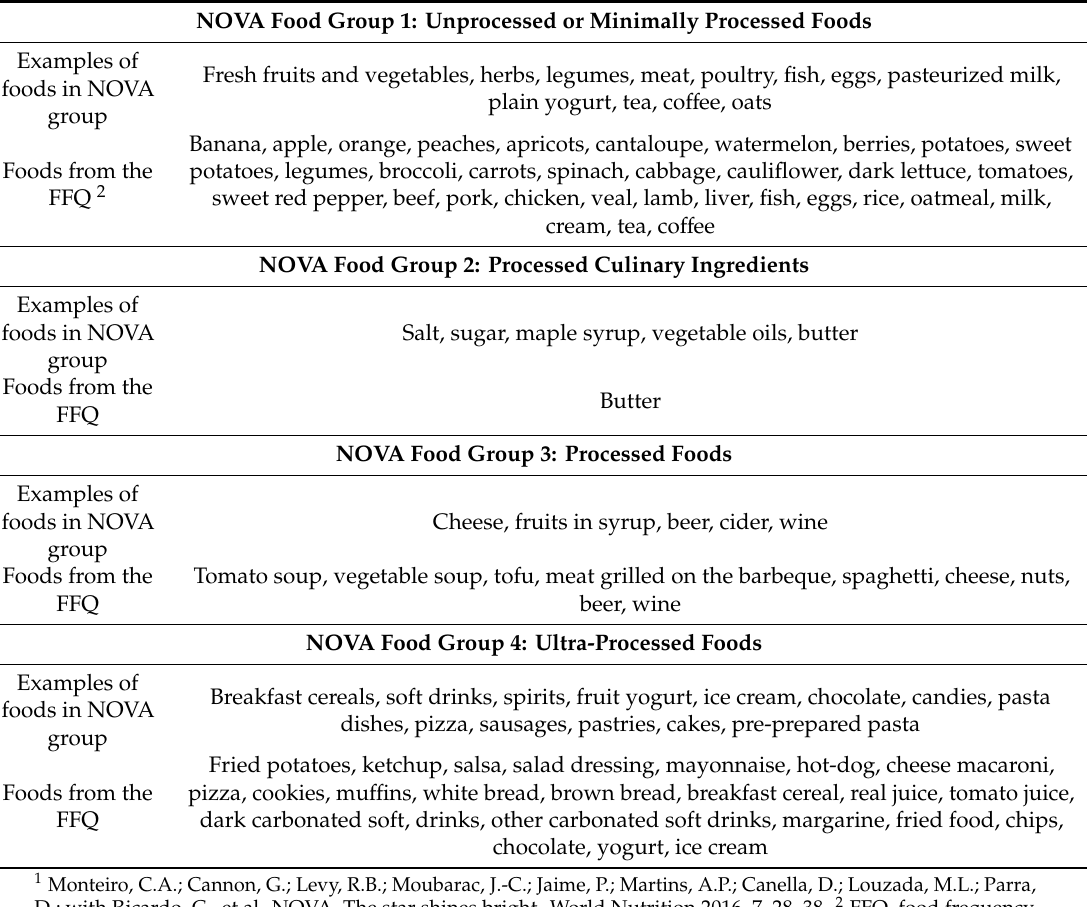
Table 1. NOVA food groups 1 and corresponding foods from the food frequency questionnaire in the Prostate Cancer and Environment Study